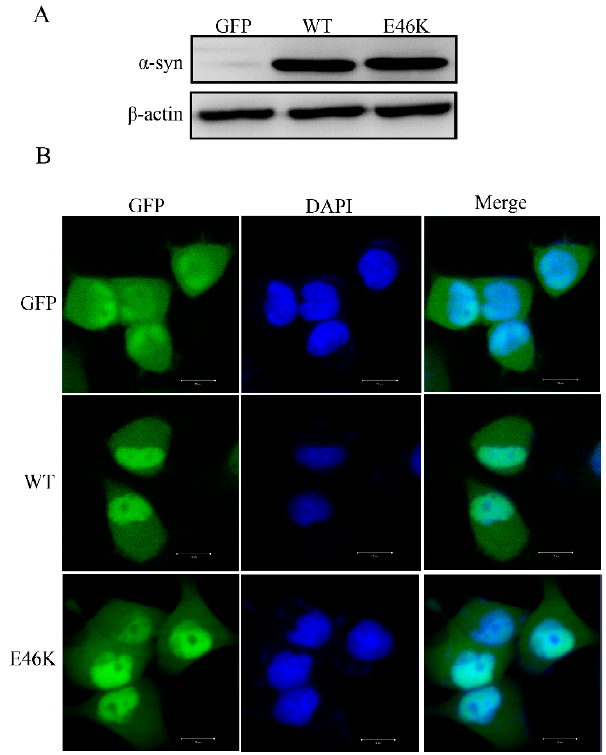
Figure 1. Establishment of PC12 cell stably overexpressing human WT and E46K mutant α -syn. ( A ) Western blotting analysis of the expression of human WT and E46K mutant α -syn. PC12 cells were transfected with pEGFP-N1- α -syn, pEGFP-N1-E46K mutant α -syn, or an empty vector using Lipofectamine 2000, according to the manufacturer’s instructions. Poly-colonies were selected in the presence of 800 µ g/mL G418. Cells were lysed and extracts were subjected to immunoblot analysis using an anti- α -syn antibody. ( B ) Immunofluorescence images of stable PC12 cells expressing E46K mutant α -syn. Scale bar: 10 mm.